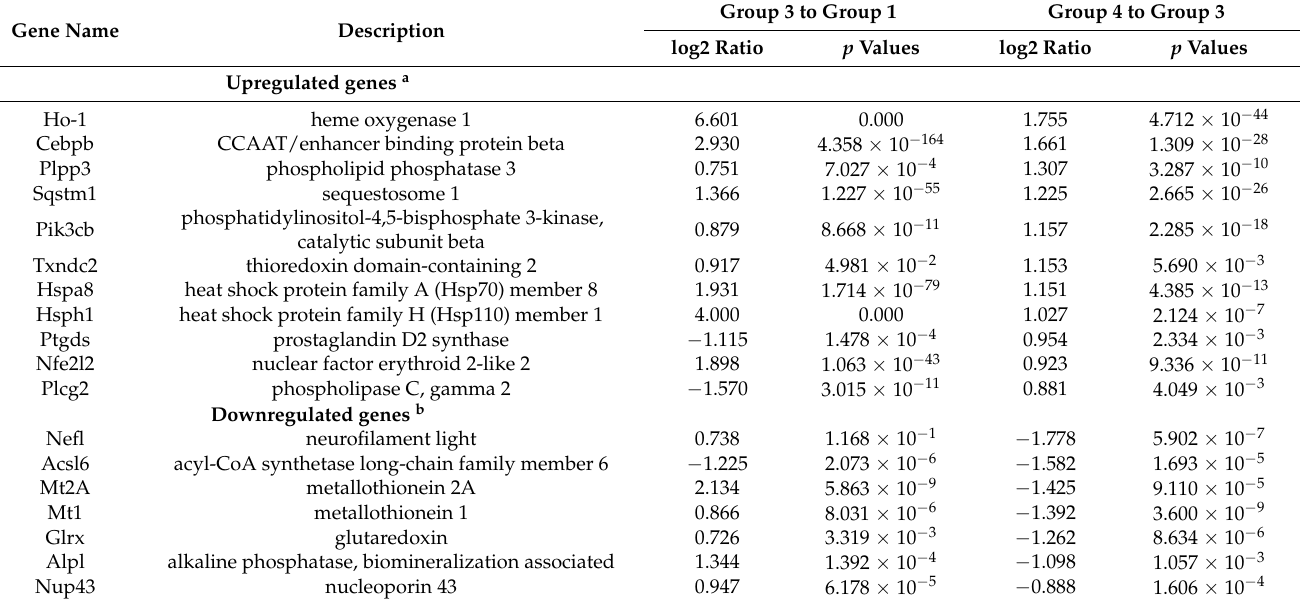
Table 2. List of representative genes whose expression was significantly changed by edaravone